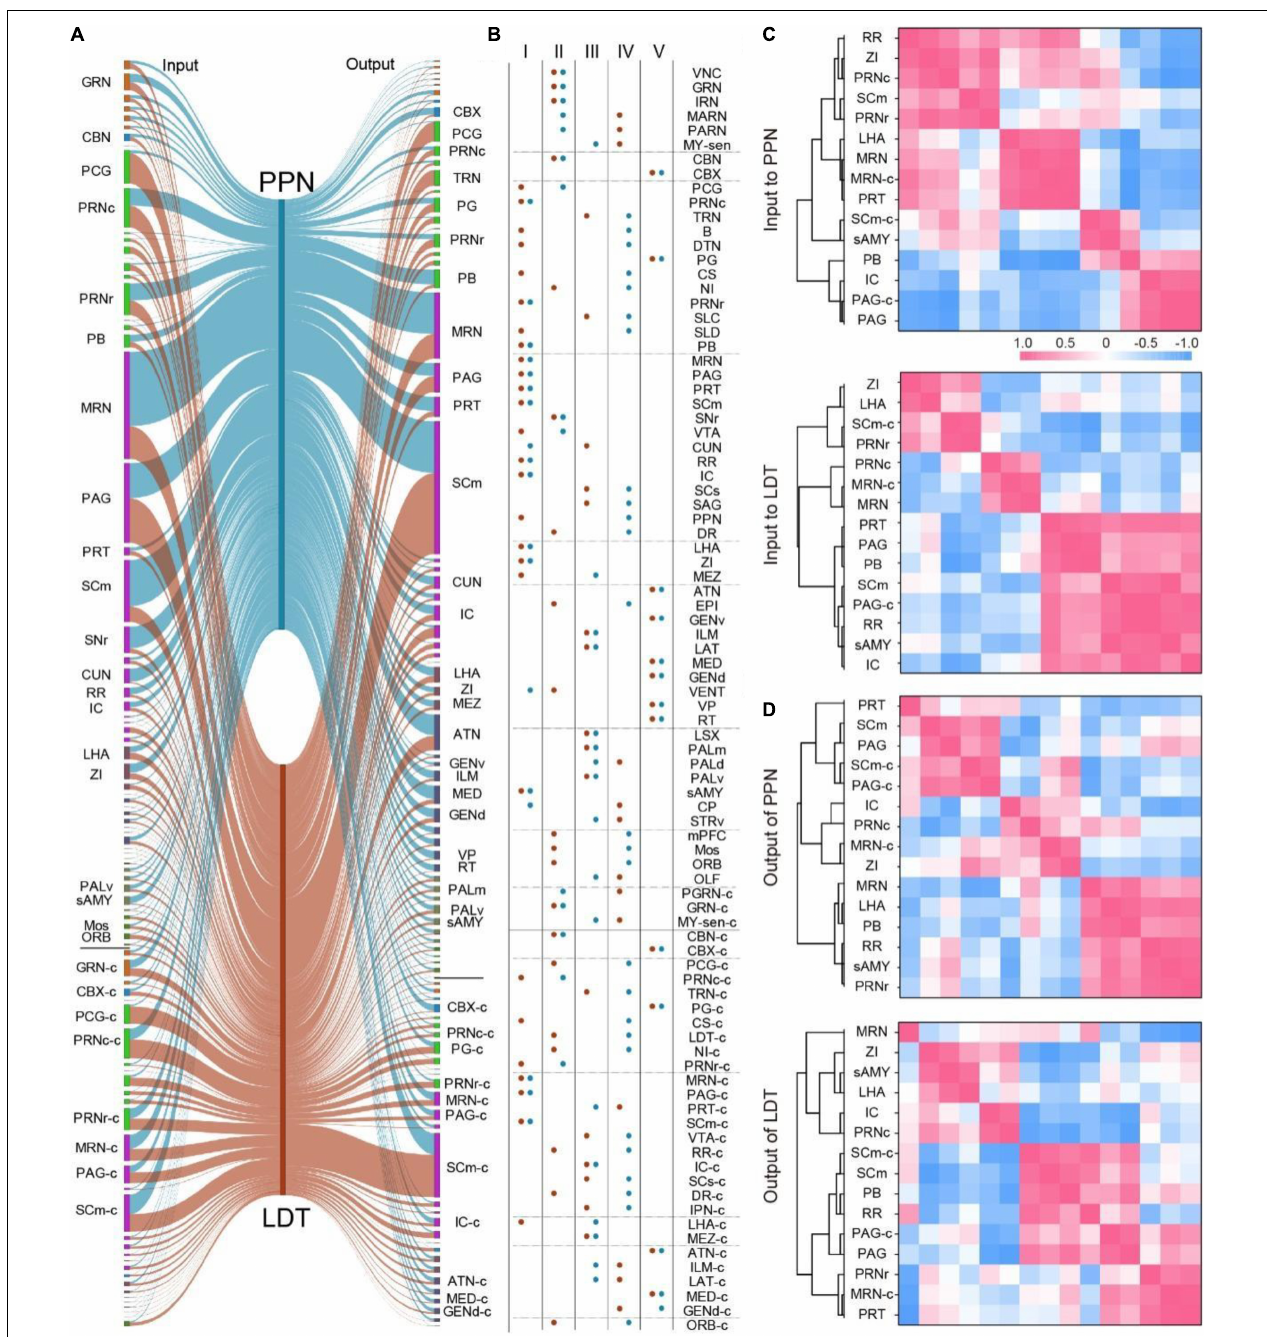
FIGURE 4 | The connectivity pattern of input and output circuits. (A) The input and output relation of 88 major connecting nuclei of ChAT PPN and ChAT LDT . The line width represents relative proportion. Nuclei with the same color belong to same regions. The abbreviations of nuclei suffixed with “-c” meant nuclei in the contralateral. (B) The major connecting nuclei were divided into five groups according to the input and output relation with ChAT PPN or ChAT LDT . The connections with PPN and LDT were displayed with blue and red, respectively. (C,D) Clustering analysis of 15 nuclei that have strong interconnections with ChAT PPN and ChAT LDT simultaneously according to the Pearson’s correlation. The abbreviations of brain regions are provided in Supplementary Table 1 .